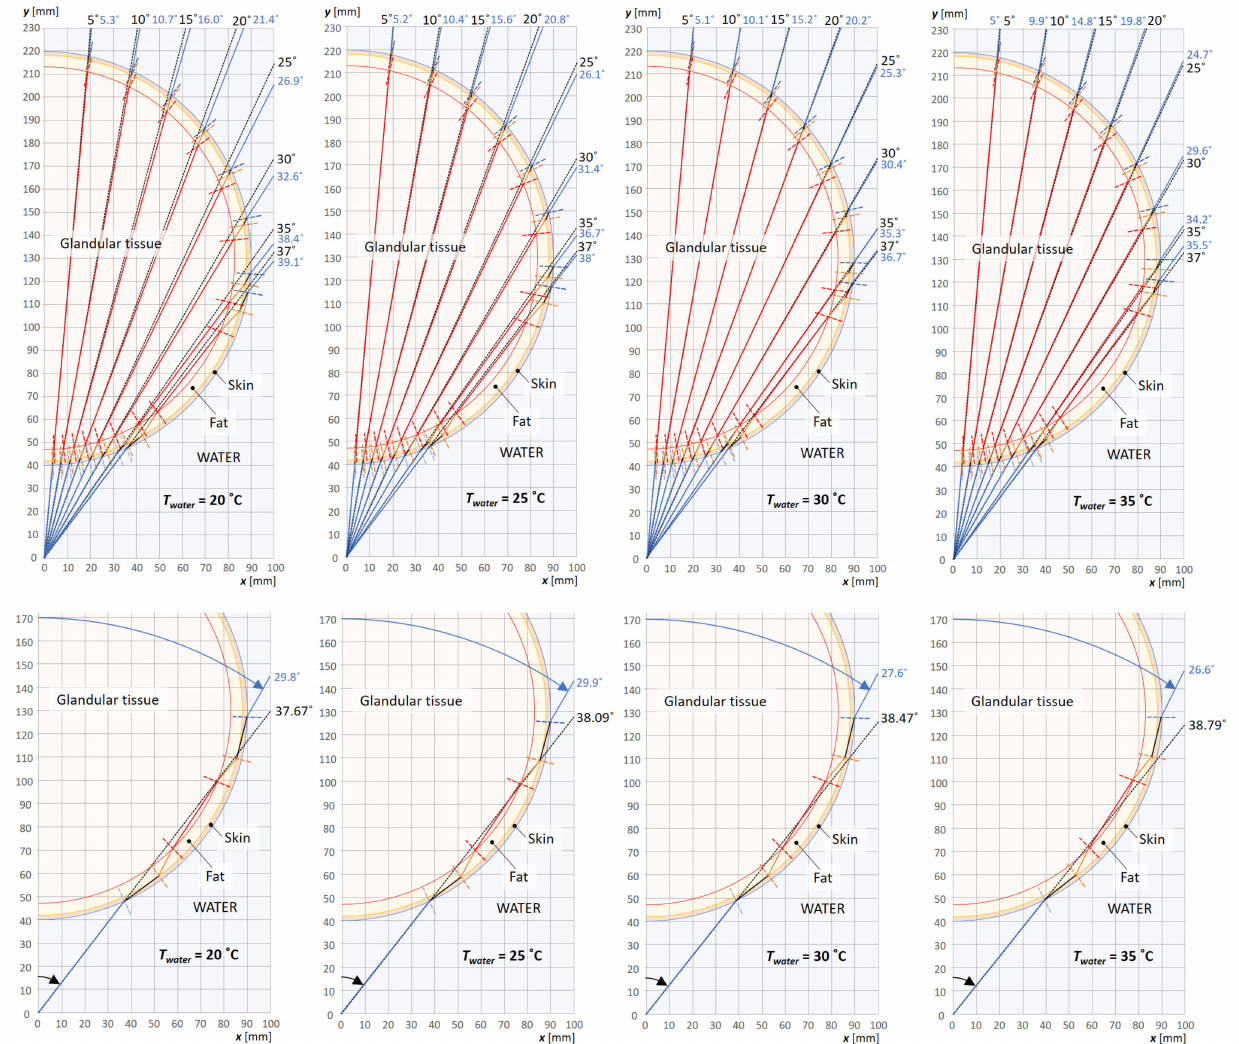
Figure 9. Results of calculating the refraction of the incident ultrasonic wave beam rays from water on curvilinear breast layers without temperature gradient in fat (see the model in Figure 8a) for angles of beam rays in the range of respectively of 5–37 ◦ (first row), as well as for the maximum possible values of the angle of beam ray still allowing this ray to pass through all layers (second row), for temperatures of 20 ◦ C, 25 ◦ C, 30 ◦ C, and 35 ◦ C